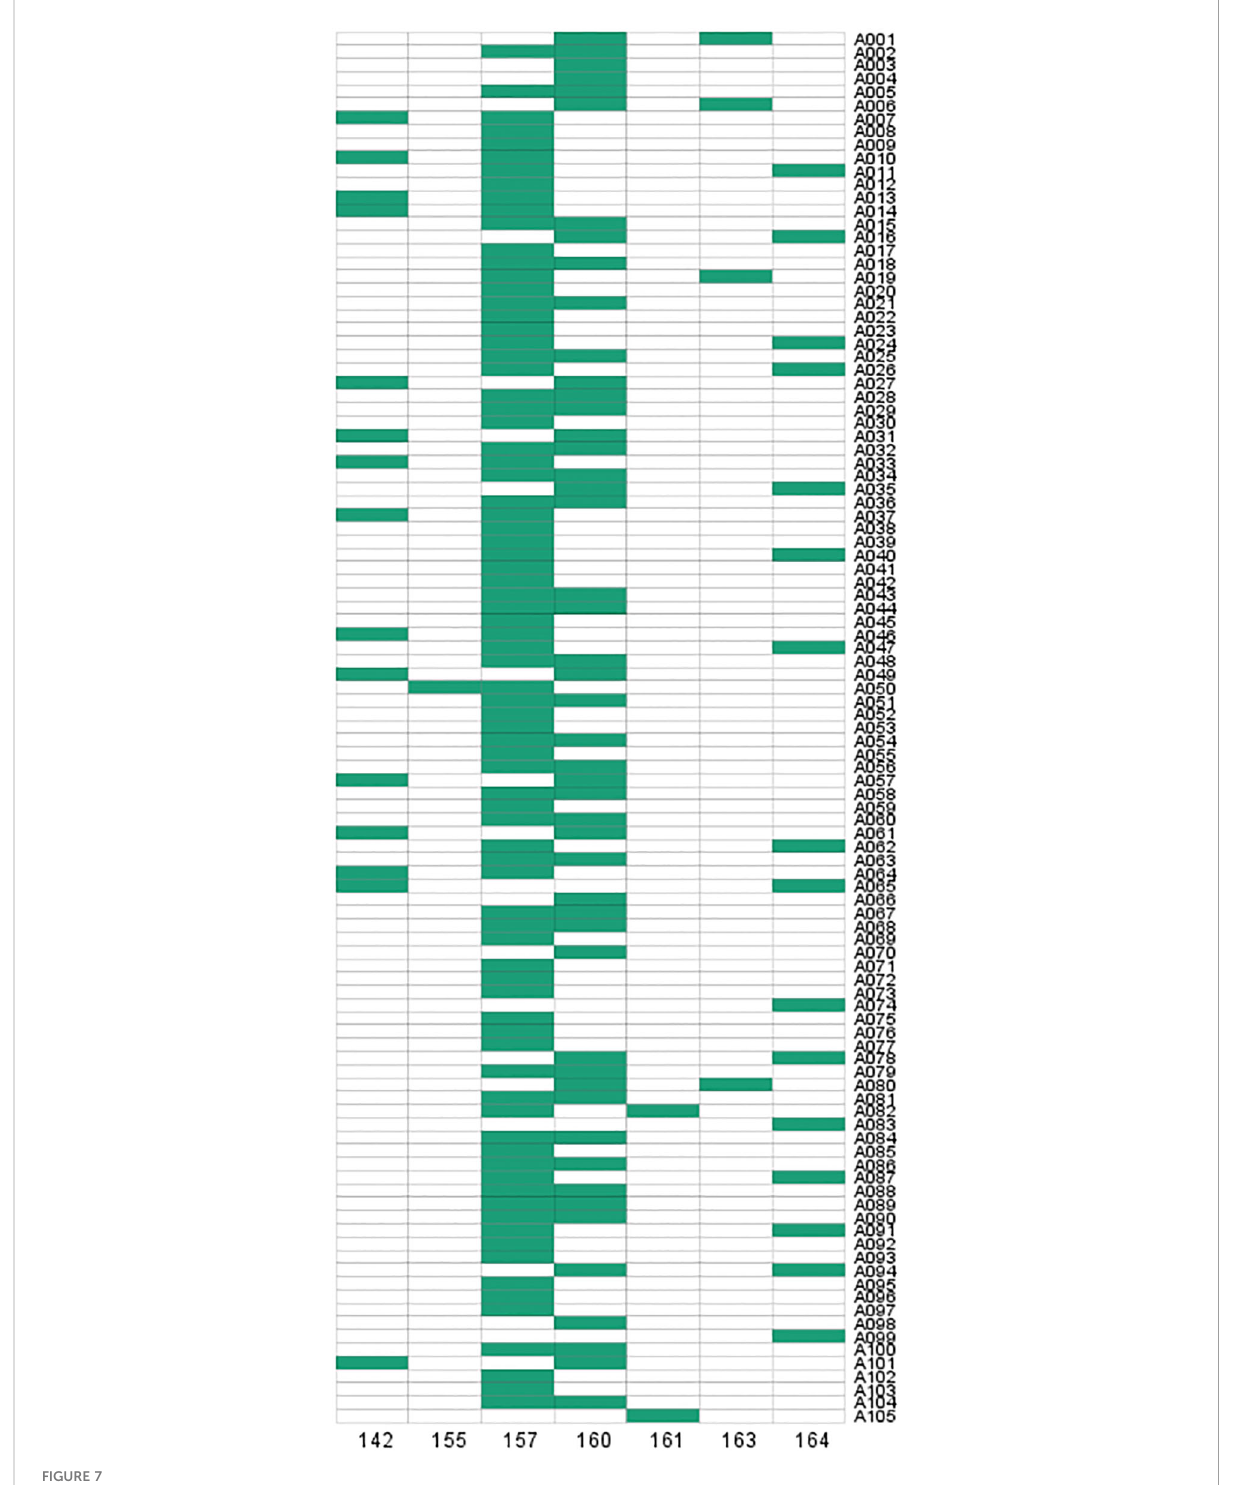
FIGURE 7 Fingerprint analysis of 105 D. odorifera samples from SSR loci in DoCCCR5